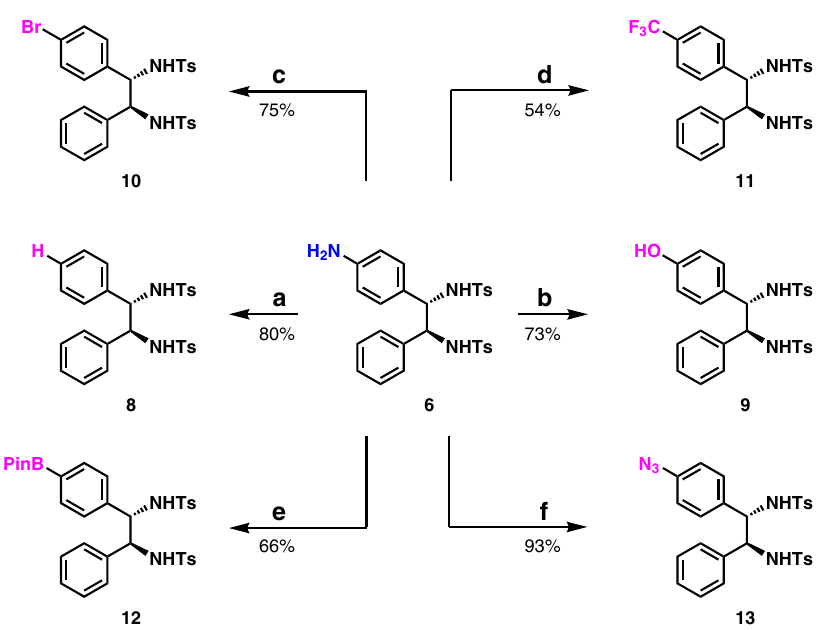
Fig. 5 Synthetic applications. a Removal of the amine moiety. NaNO 2 , HCl, H 3 PO 2 , H 2 O, 0 °C. b transformation of the arylamine to phenol. NaNO 2 , H 2 SO 4 , H 2 O, 0 to 100 °C. c transformation of the arylamine to arylbromide. CuBr 2 (1 mol %), t BuONO, TsOH, TBAB, MeCN, RT. d transformation of the arylamine to tri fl uoromethyl arene. t BuONO, HCl, AgCF 3 , MeCN, − 40 °C. e Transformation of the arylamine to arylBPin. t BuONO, B 2 Pin 2 , MeCN, 80 °C. f Transformation of the arylamine to aryl azide. KHCO 3 , FSO 2 N 3 , MTBE/DMF/H 2 O,